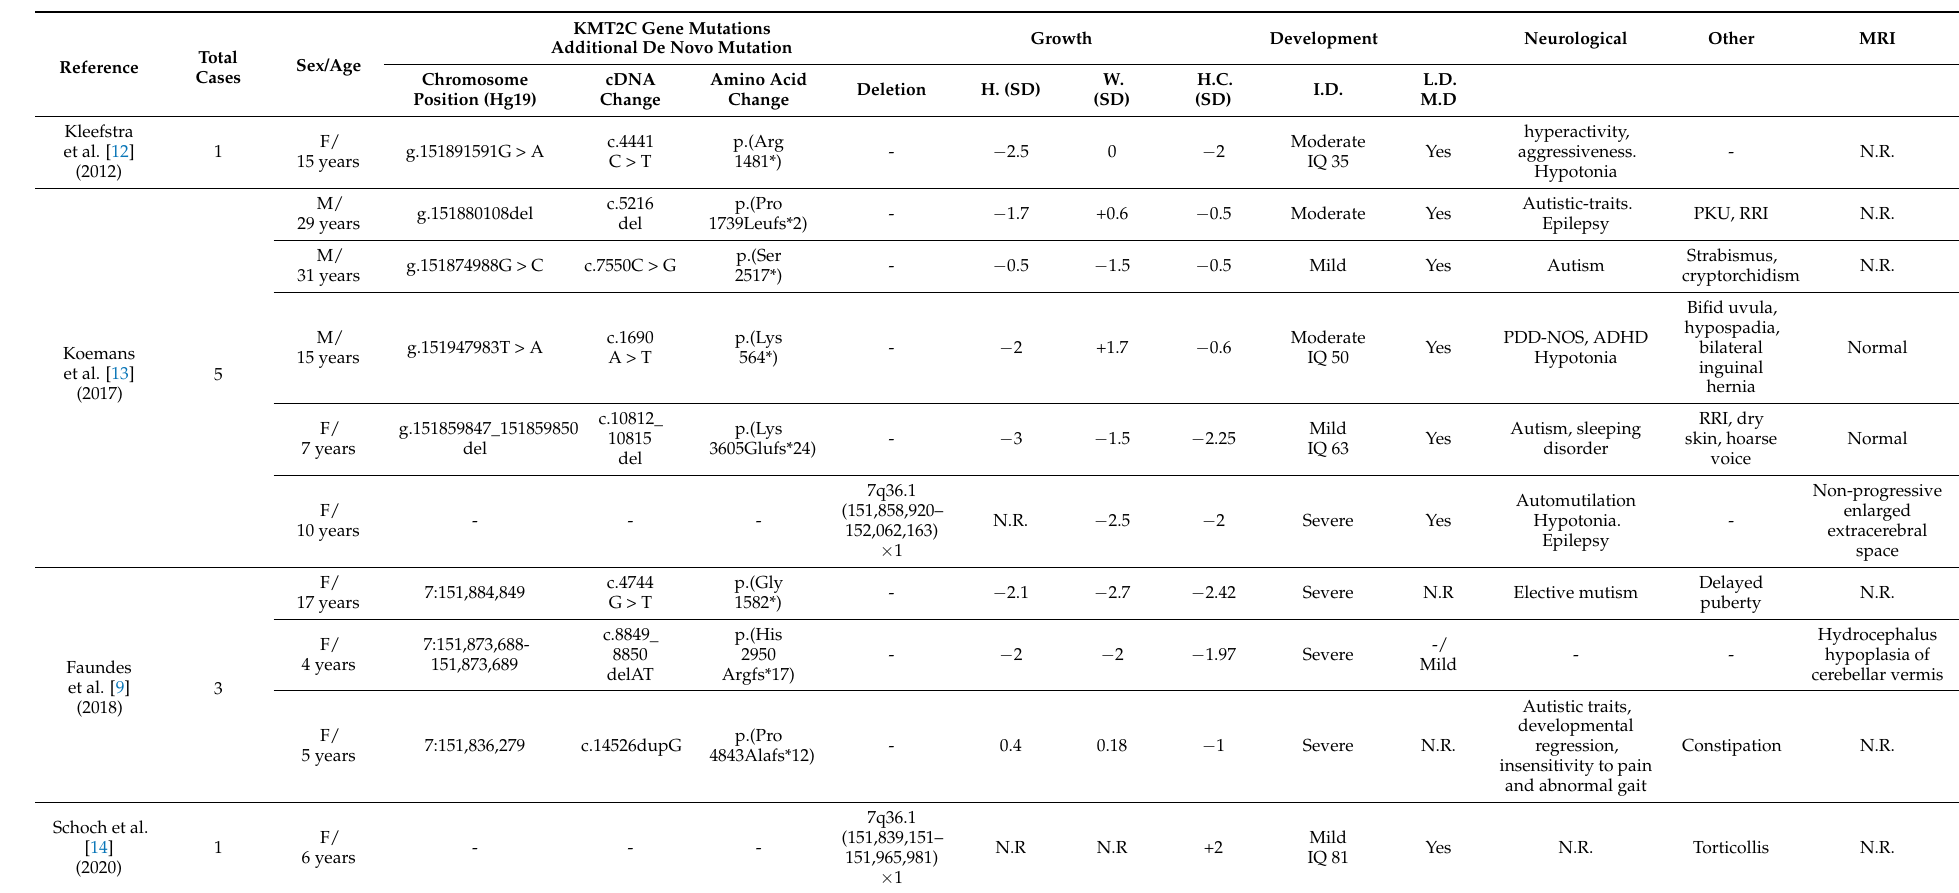
Table 1. Clinical and genetic characteristics of affected individuals with KMT2C